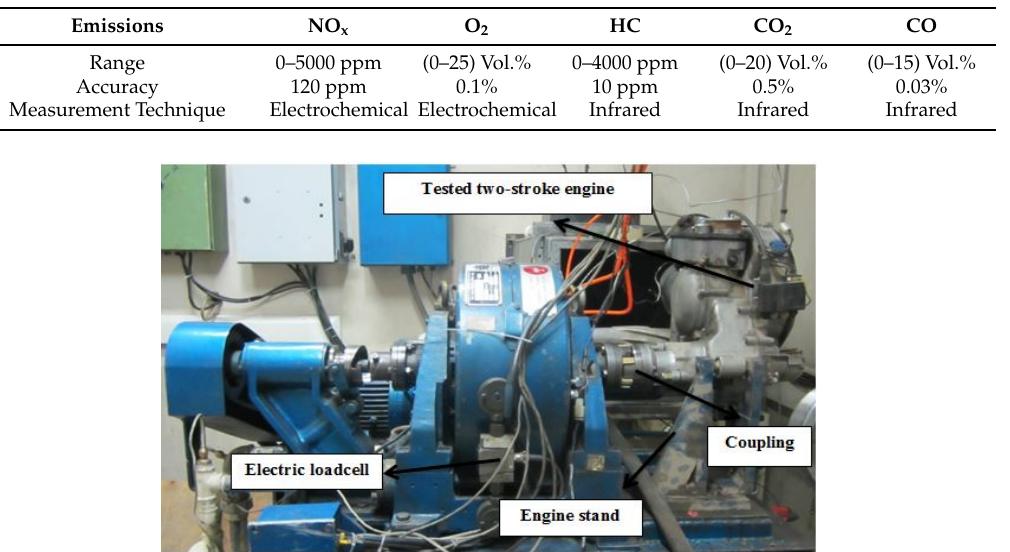
Table 2. The two ‐ stroke engine’s technical specification.